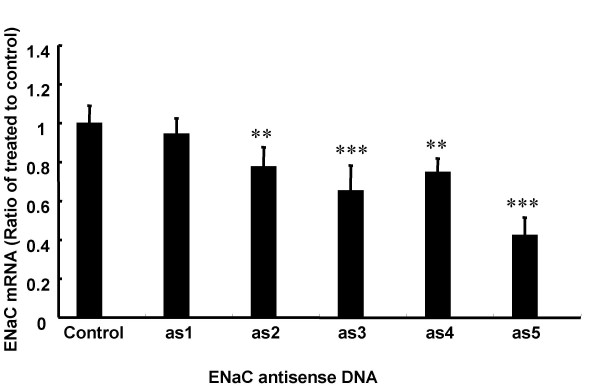
In vitro screening of ENaC asODN in M1 cells. M1 cells were transfected with 5 different αENaC asODN and a control ODN complexed to Lipofectamine 2000. Forty-eight hours after transfection mRNA was extracted and αENaC mRNA was quantified. Data are presented as mean +/- SEM. ** indicates p < 0.01 and *** = p < 0.001 when compared to control, n = 6/group.